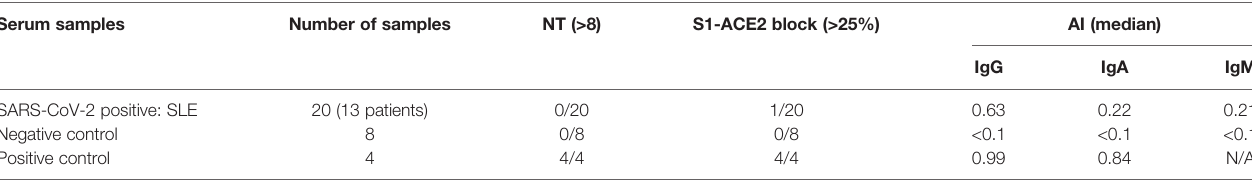
TABLE 3 | Serological virus-inhibition analysis of S1 ELISA-reactive sera. Serum